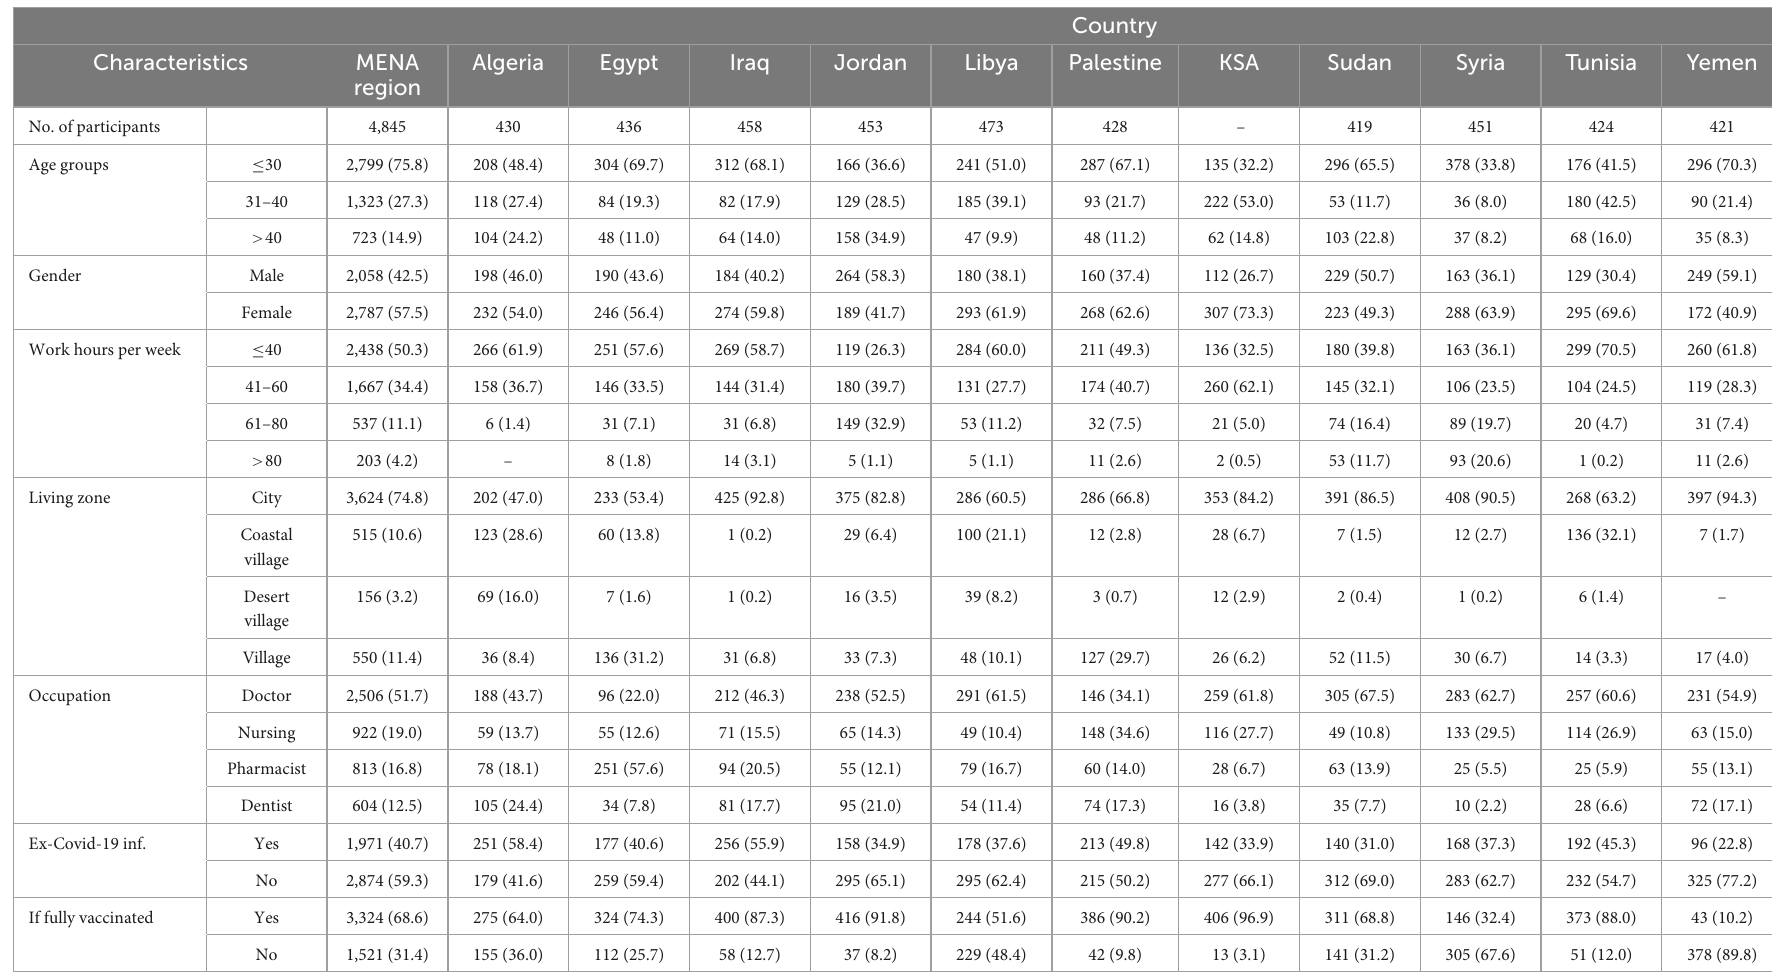
TABLE 2 The socio-demographic and occupational characteristics of the healthcare workers in the Middle East and North Africa (MENA)